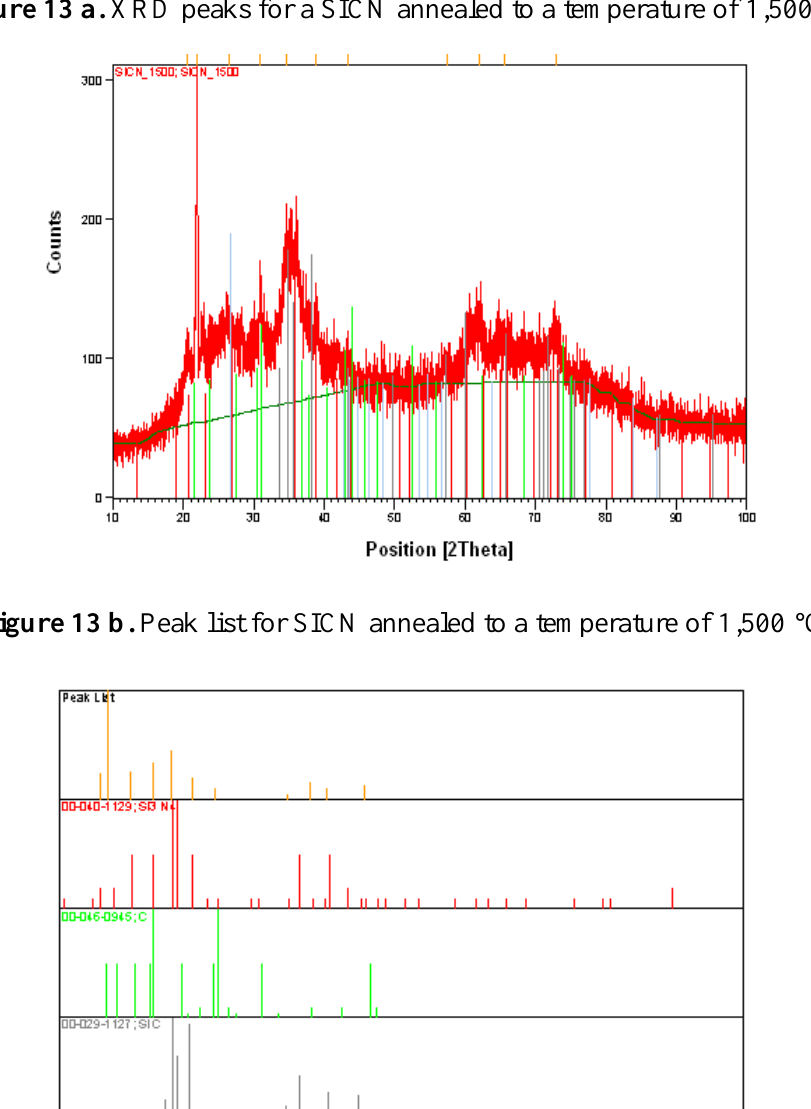
Figure 13 a. XRD peaks for a SICN annealed to a temperature of 1,500 °C.